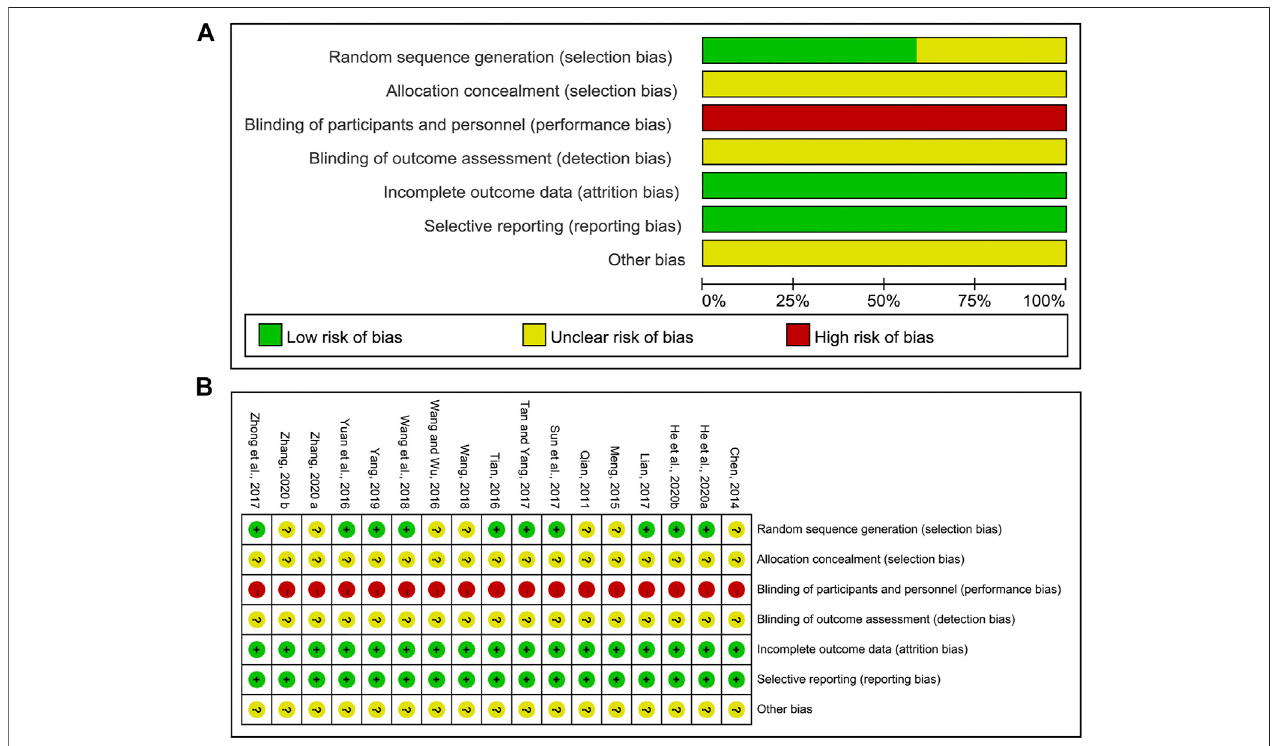
FIGURE 2 | Risk of methodological bias of the included studies. (A) Risk of bias graph. (B) Risk of bias summary.